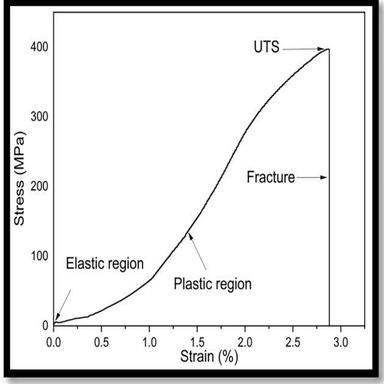
Stress-Strain curve.